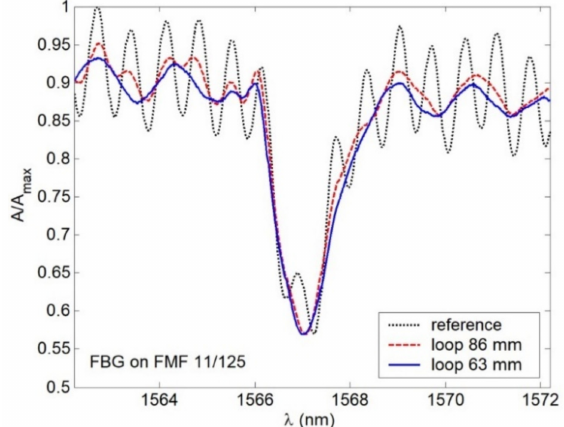
Figure 15. Spectral responses under 86 and 63 mm loops, placed over FMF 11/125 with written